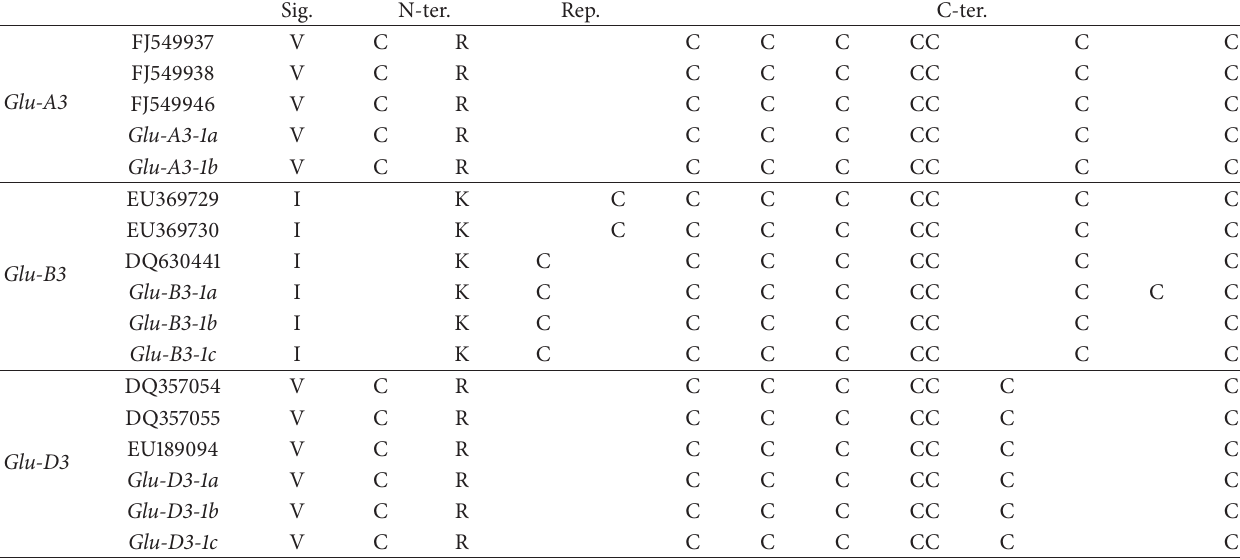
Table 3: Comparison of the deduced amino acid sequences for genes isolated in this study and data from GenBank. Sig. N-ter. Rep. C-ter.